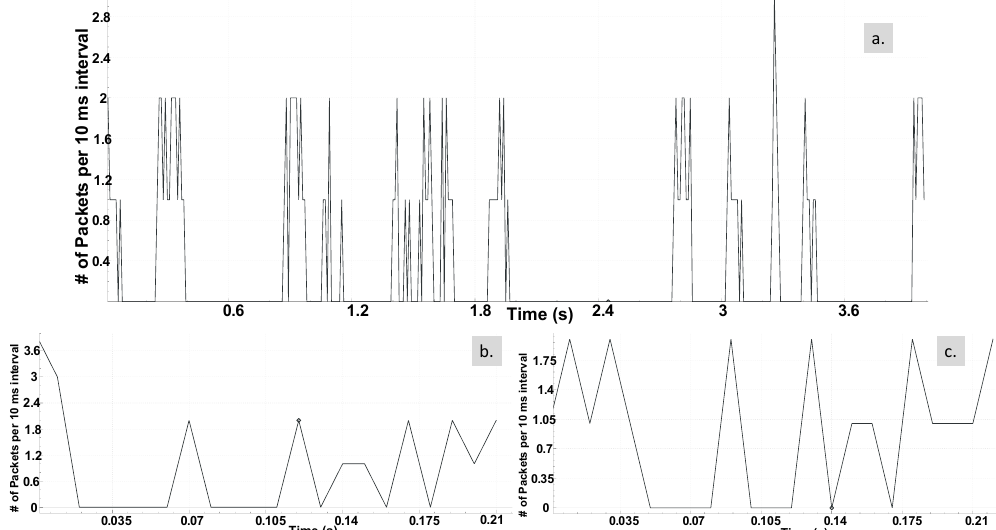
Figure 13. Communication throughput: ( a ). Generic, object-oriented substation events (GOOSE) exchanges between STL and DERs (average latency ≈ 5 ms). ( b ). Load request correction from FOL to STL (average latency ≈ 10 ms). ( c ). Load estimate query from STL to